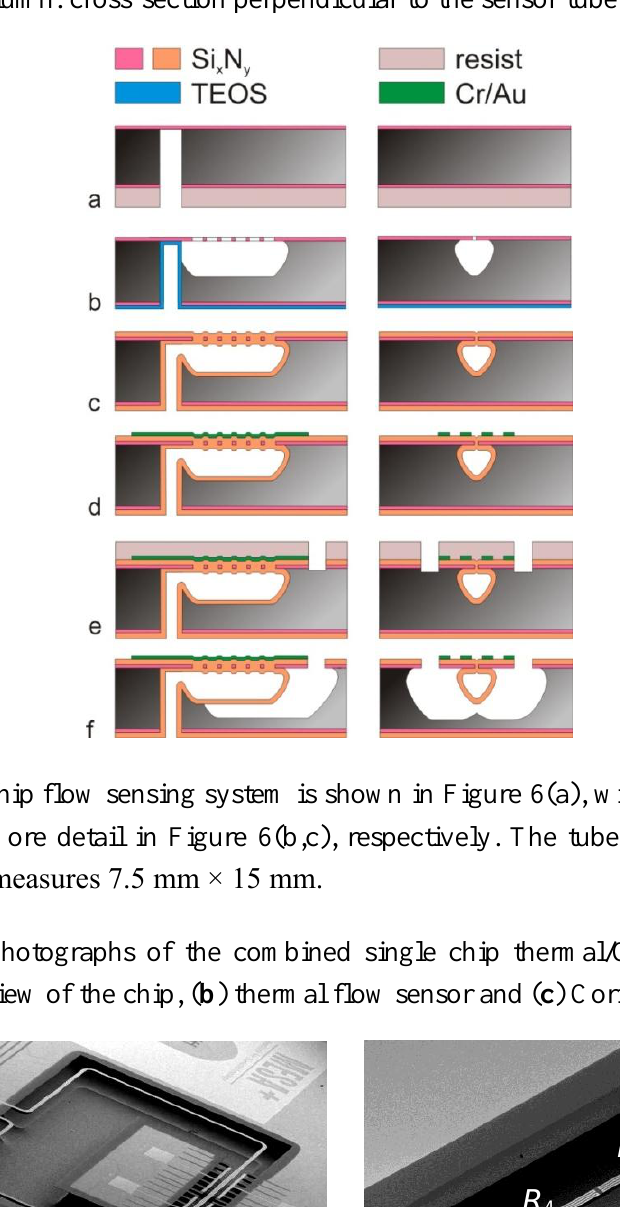
Figure 5. Outline of the fabrication process. Left column: cross-section along the length of the tube. Right column: cross-section perpendicular to the sensor tube.